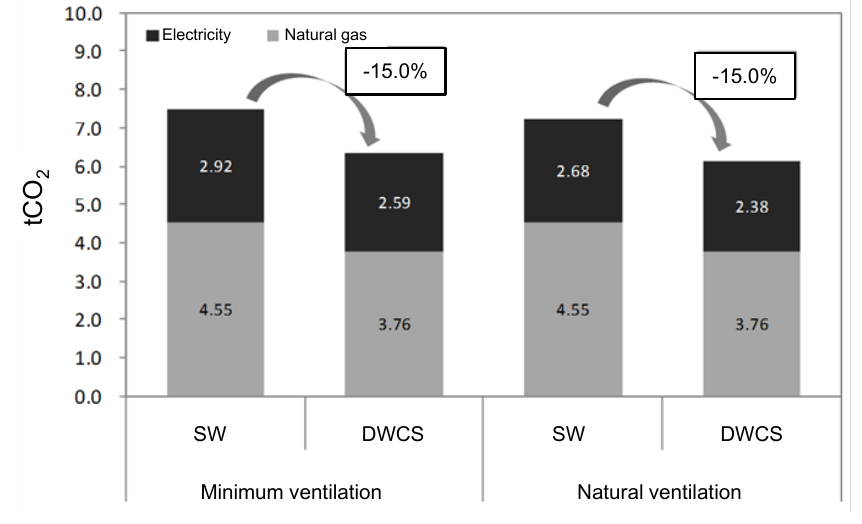
Figure 11. Reduction in annual CO 2 emissions for overall operation.